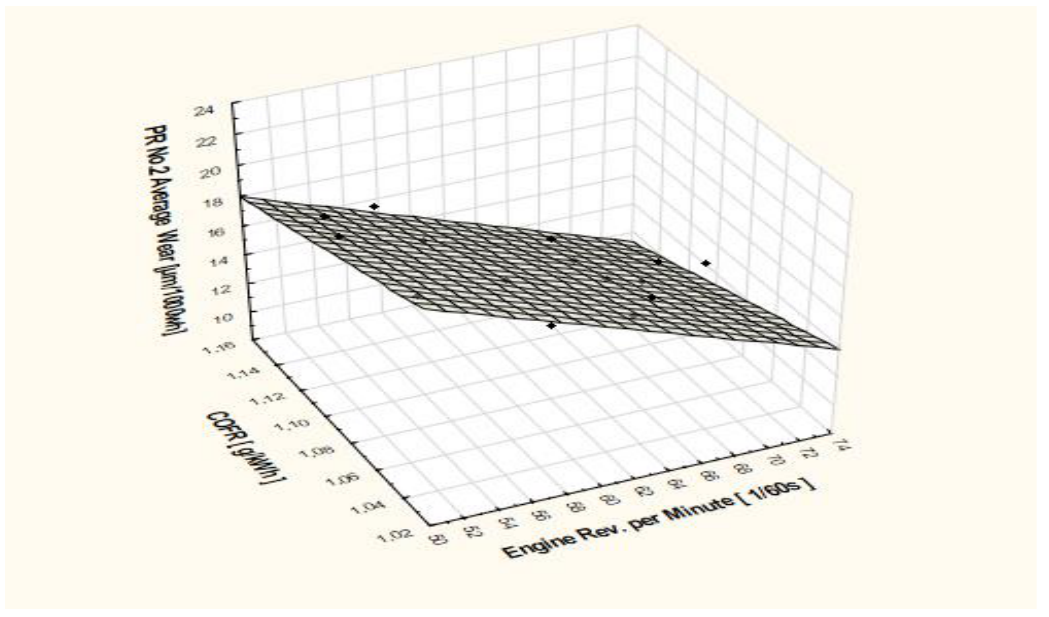
Figure 4. Results of average wear rates for PR No. 2 in all engine units, depending on COFR and the engine’s RPM (piston speed).